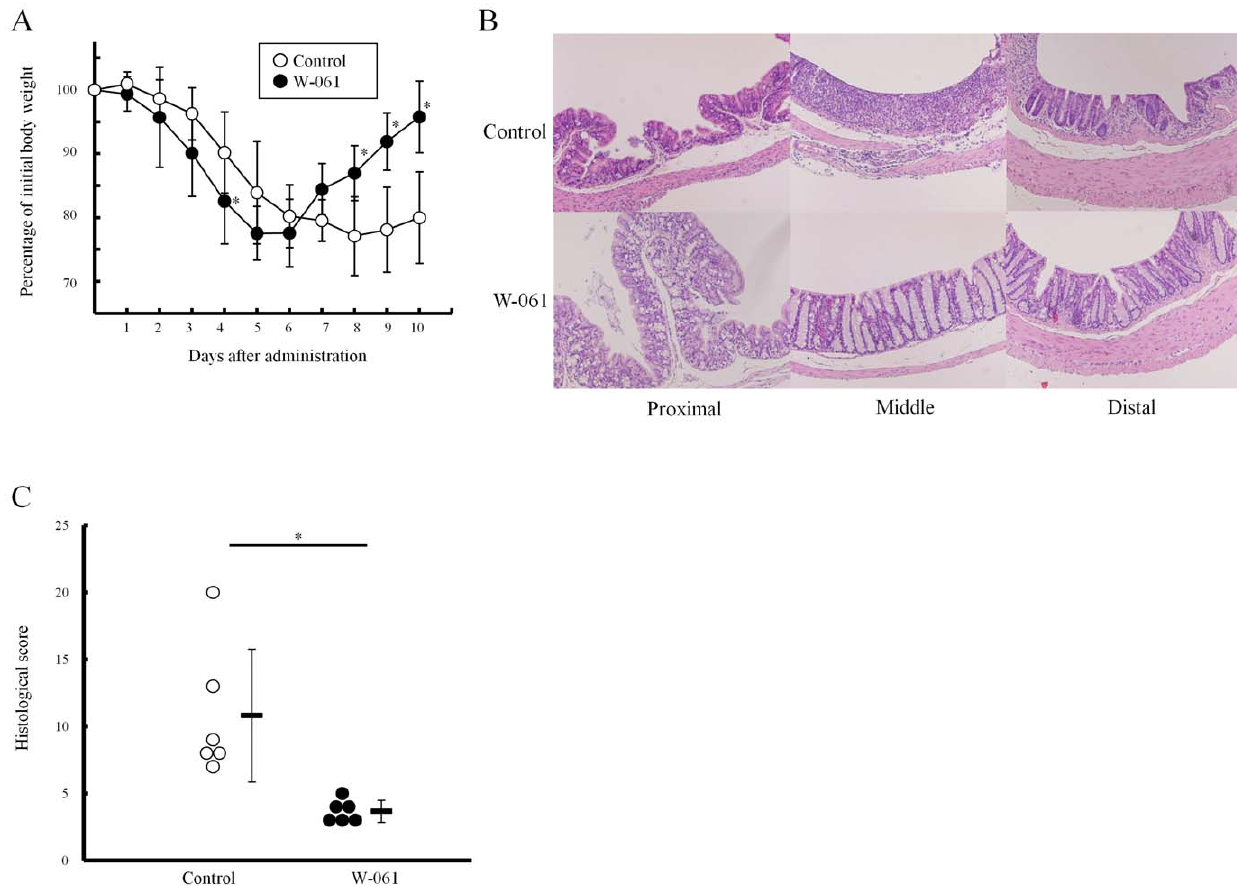
Figure 1. DSS-induced colitis was ameliorated by W-061 treatment. (A) Change in body weight of W-061-treated and control mice with the DSS-induced colitis (n=6 mice for each group, *p , 0.05). (B) Pathological evaluation of the DSS-induced colitis on day 10. (C) Histological score of the DSS-induced colitis on day 10. Data represent absolute values (means 6 SD, n=6 mice for each group, *p , 0.05).